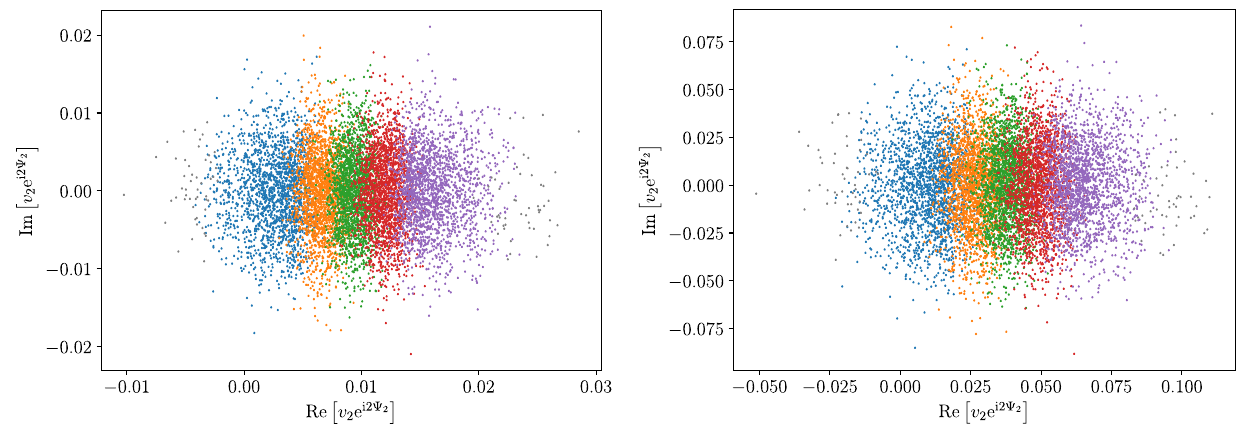
Fig. 10 Scatter plot of the final complex elliptic flow v 2 e 2i (cid:5) 2 ≡ v 2 , c + i v 2 , s for events at b = 6 fm with (cid:3) Kn (cid:4) − 1 = 0 . 34 (left) and (cid:3) Kn (cid:4) − 1 = 13 . 74 (right). The bins are those in ε 2 , c as in Figs. 4 and 9